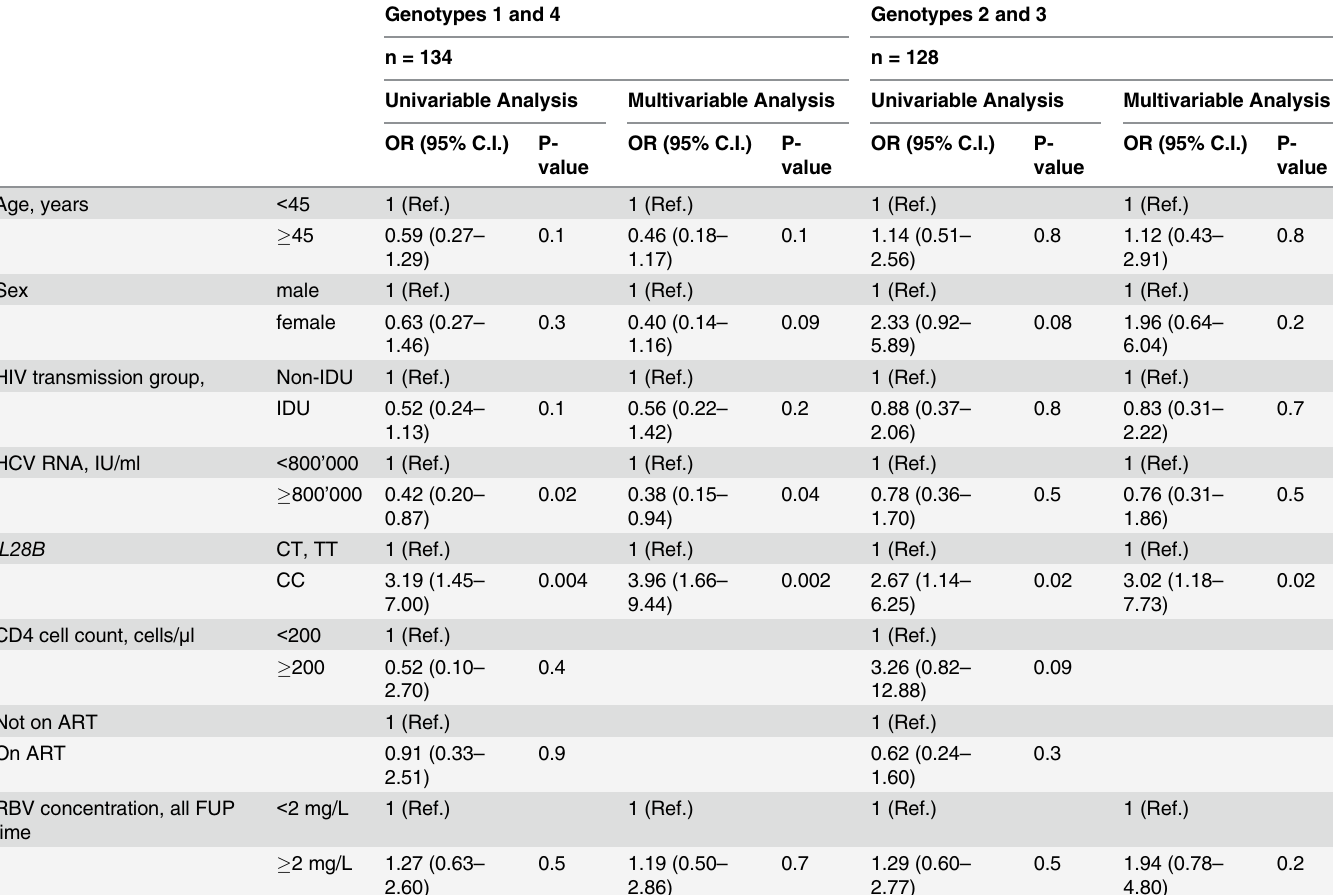
Table 3. Uni- and multivariable logistic regression analyses regarding factors associated with sustained virological response (SVR), stratified by HCV genotype